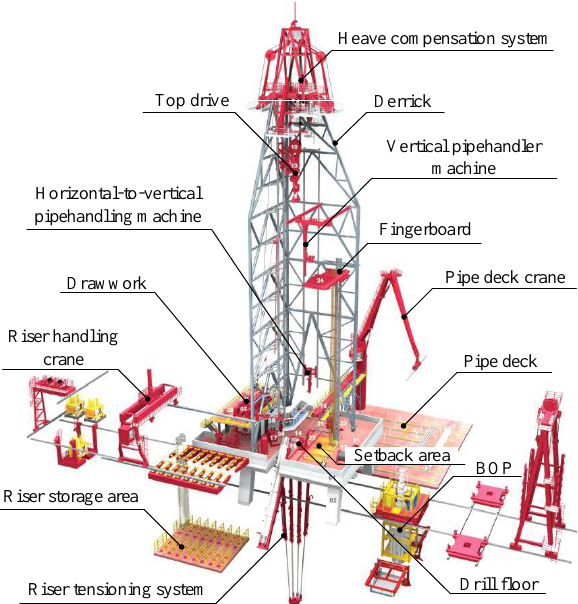
Figure 1: Typical drilling rig layout. Image courtesy of Bak